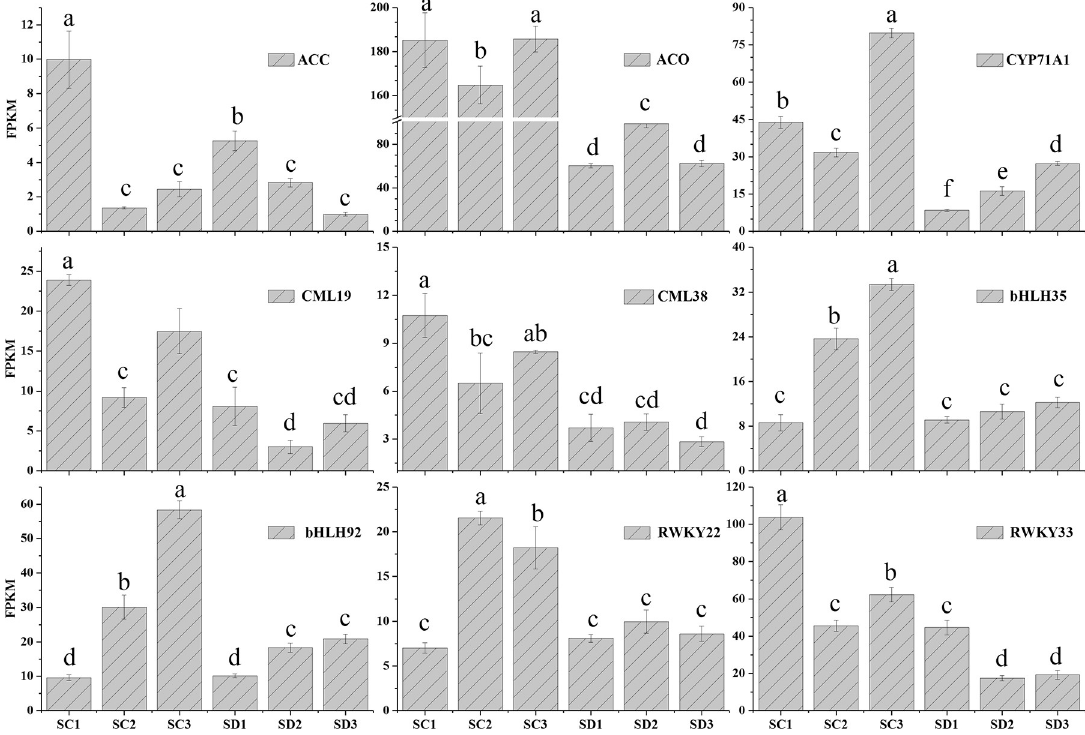
Fig 7. Expression analyses of genes related to hormones or transcription factors. The x-axis indicates the different stages. The y-axis shows the expression values of the FPKMs. All values were repeated three times and the data are presented as the mean ± SD. Different letters indicate significant differences at P < 0.01. ACC: CU_locus32671; ACO: CU_locus22526; CYP71A1: CU_locus30850; CML19: CU_locus33375; CML38:CU_locus24324; bHLH35: CU_locus1151; bHLH92: CU_locus476; WRKY22: CU_locus16052; WRKY33: